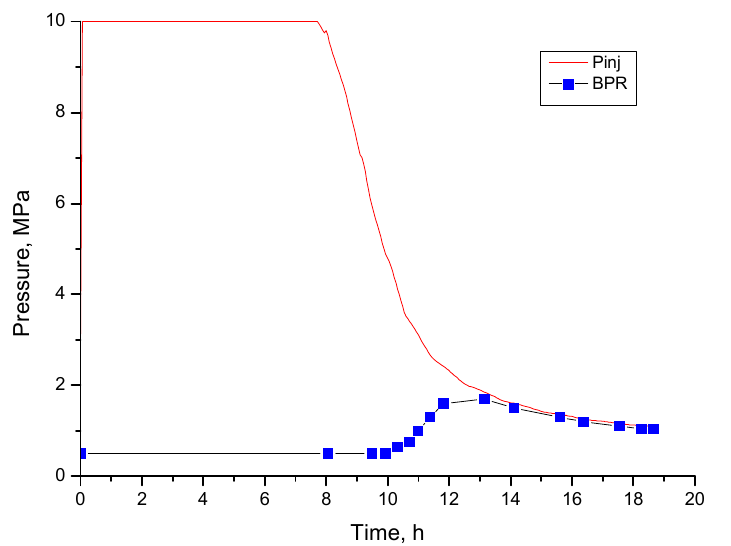
Figure 6. Injection pressure and back pressure of high-permeability coreholder with time.